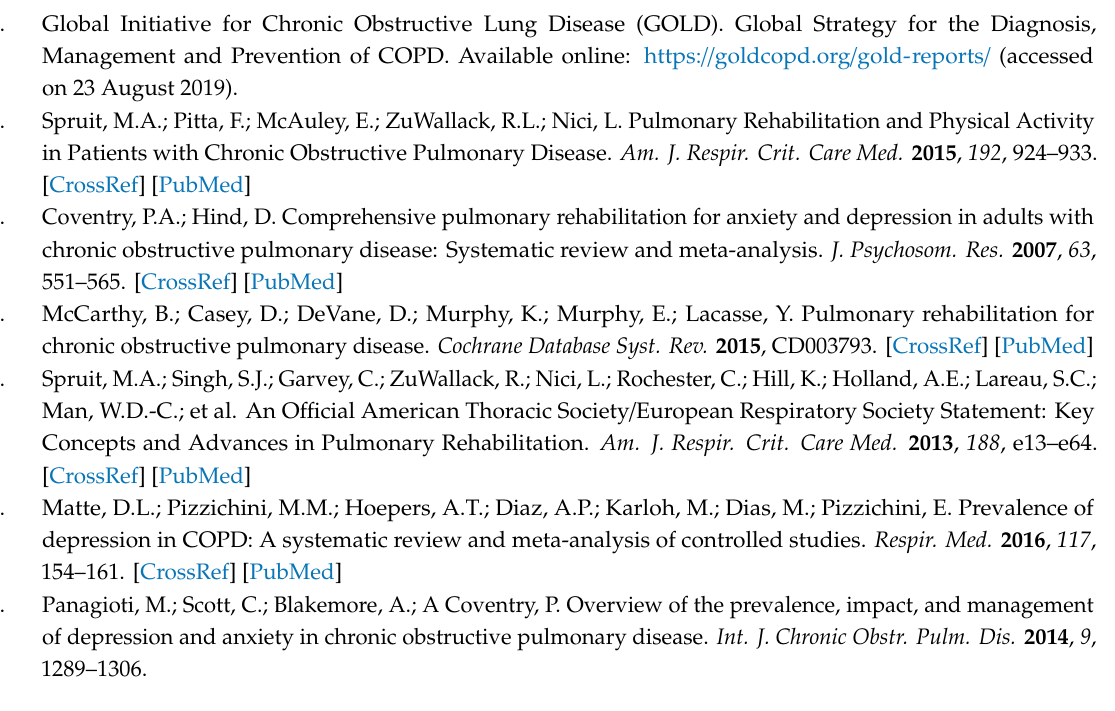
Table S1: Change in Disease-Specific Fears and other Pulmonary Rehabilitation Outcomes-including covariates; Table S2: Correlations between disease specific fears at baseline with within-individual means and SD. Author Contributions: This study makes use of data collected in the context of the STAR-study, which was conceived, designed and implemented by W.G., K.S., N.L., M.W., J.C. and K.P. Contributions for the current study: conceptualization, A.v.L., K.S. methodology, T.J.; data analysis, T.J., Z.V.d.M.; investigation, A.v.L., T.J.; data curation, J.C., W.G., M.W., N.L.; Writing—Original draft preparation, T.J., Z.V.d.M., A.v.L.; Writing—Review and editing, All Authors.; visualization, T.J.; project administration, W.G., K.P., J.C., K.S.; funding acquisition, W.G., K.P., K.S., A.v.L. Funding: This research was supported by the German Pension Insurance Association, Section Bavaria South (Reference number: 5.011-6.031.115), as well as the “Asthenes” long-term structural funding Methusalem grant (METH / 15 / 011) by the Flemish Government,